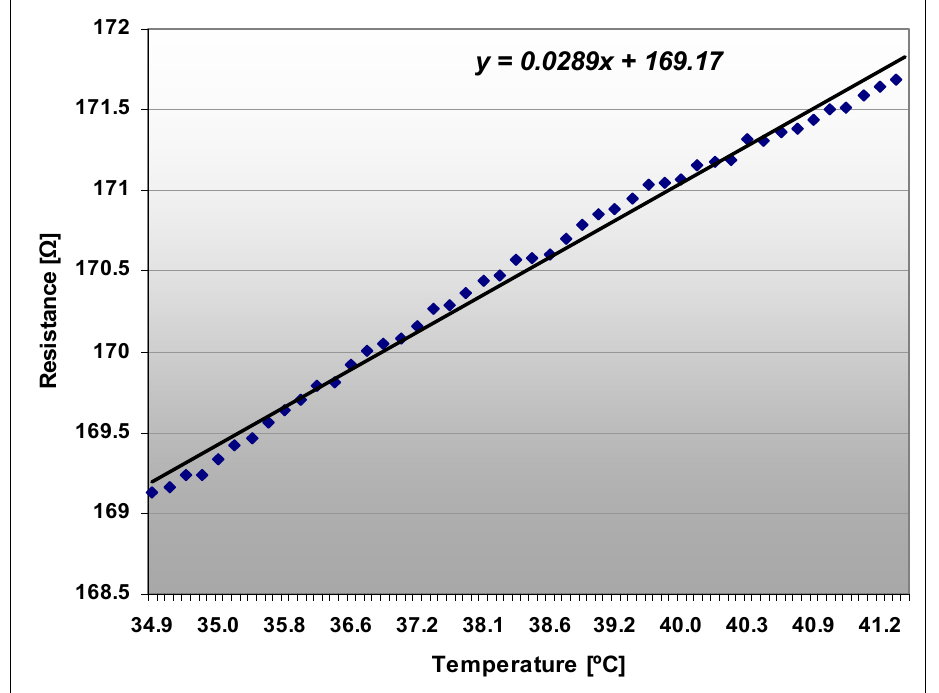
y = 0.0289x + 169.17